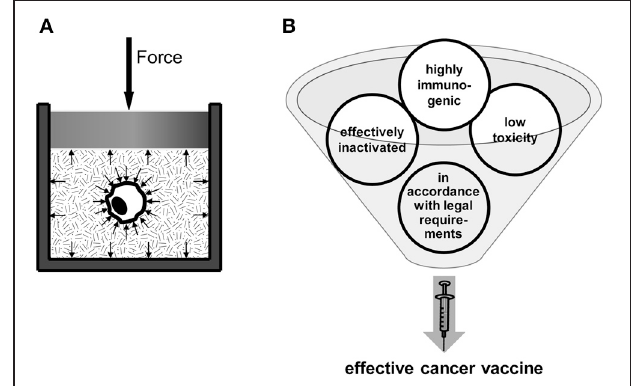
FIGURE 2 | High hydrostatic pressure (HHP) Technology as an innovative method for the preparation of whole tumor cell-based vaccines. The basic principle of the HHP technology is displayed in (A) . The tumor cell suspension, which has to be pressurized, has to be packed in a plastic wrapping. The pressure is applied to the treatment cavity and propagates through the pressure transmitting medium and also through the packaging (Yaldagard et al., 2008). Since the pressure is a vector product its acts on every material in the cavity with the same amplitude, independent of the shape of the probe. It was obvious in different experiments, that the pressure for inactivation should be at least equal or above 200MPa. For the production of an effective whole cell-based vaccine, four main requirements have to be fulfilled (B) : the vaccine has to be safe, i.e., it has to exhibit low toxicity and, especially in the case of autologous tumor cell-based vaccines, the tumor cell material has to be effectively inactivated. The vaccine has to be further highly immunogenic, i.e., it has to trigger the immune system to elicit a strong anti-tumor response accompanied by the development of an immunological memory against the tumor. Finally, the vaccine and its processing have to be in accordance with statutory provisions.